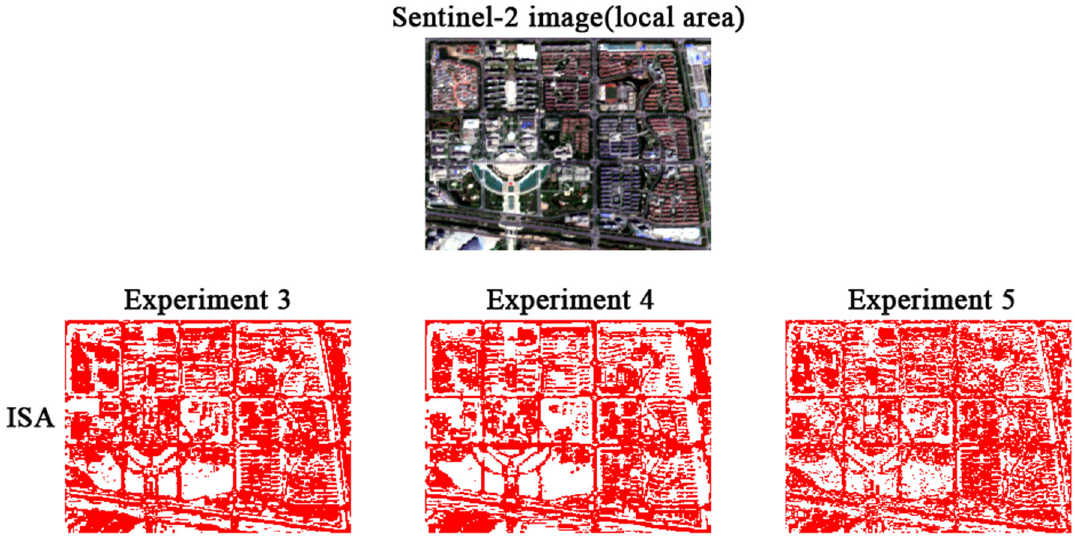
Figure 7. ISA classification results for different classifiers.